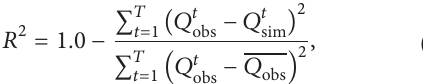
Figure 3: Diagram of BMA(9) combination